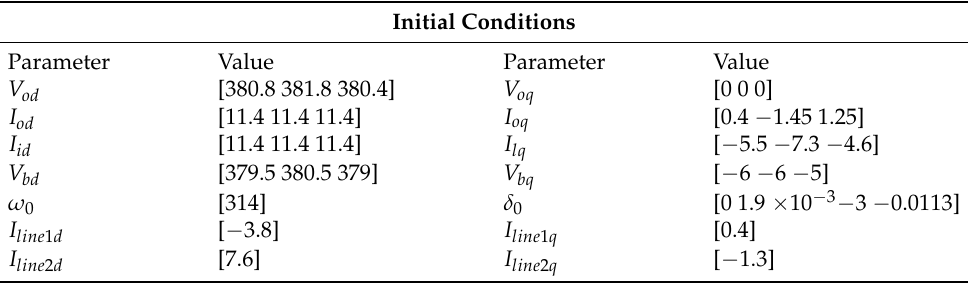
Table 3. Microgrid initial